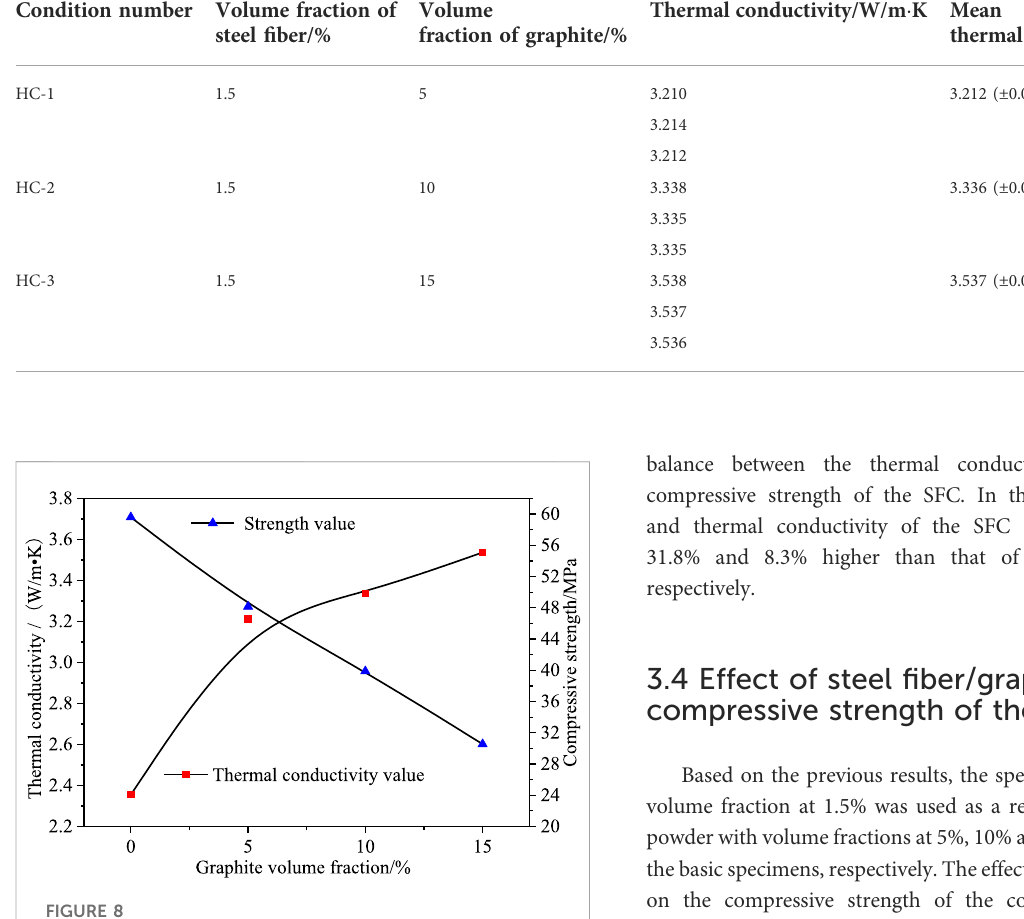
FIGURE 8 Thermal conductivity andstrengthvariationlaw withgraphite volumefraction,whenthevolumefractionofthesteel fi